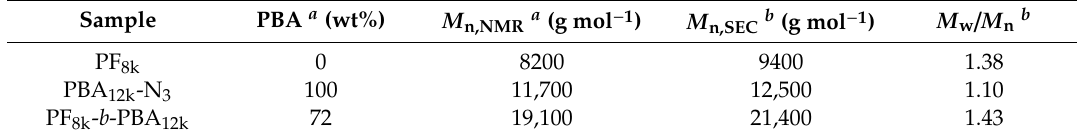
Figure 1. ( a ) 1 H-NMR spectrum of the PF 8k - b -PBA 12k in CDCl 3 and ( b ) FTIR spectra of the PF 8k , PBA 12k -N 3 and PF 8k - b -PBA 12k copolymers. Table 1. Molecular characteristics of the PF 8k , PBA 12k -N 3 and PF 8k - b -PBA 12k copolymers.